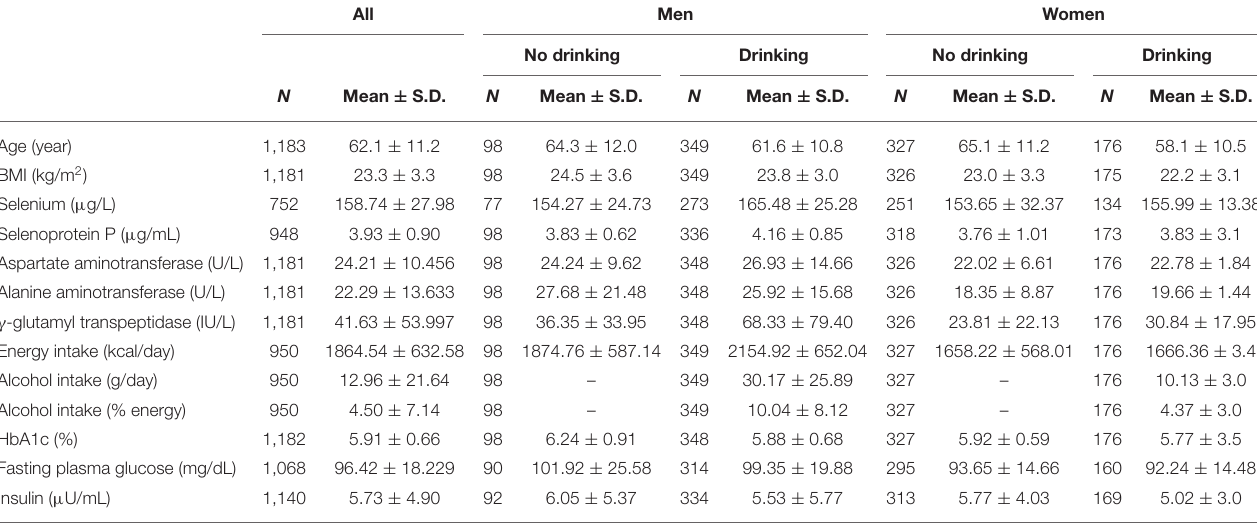
TABLE 1 | Characteristics of the study participants.